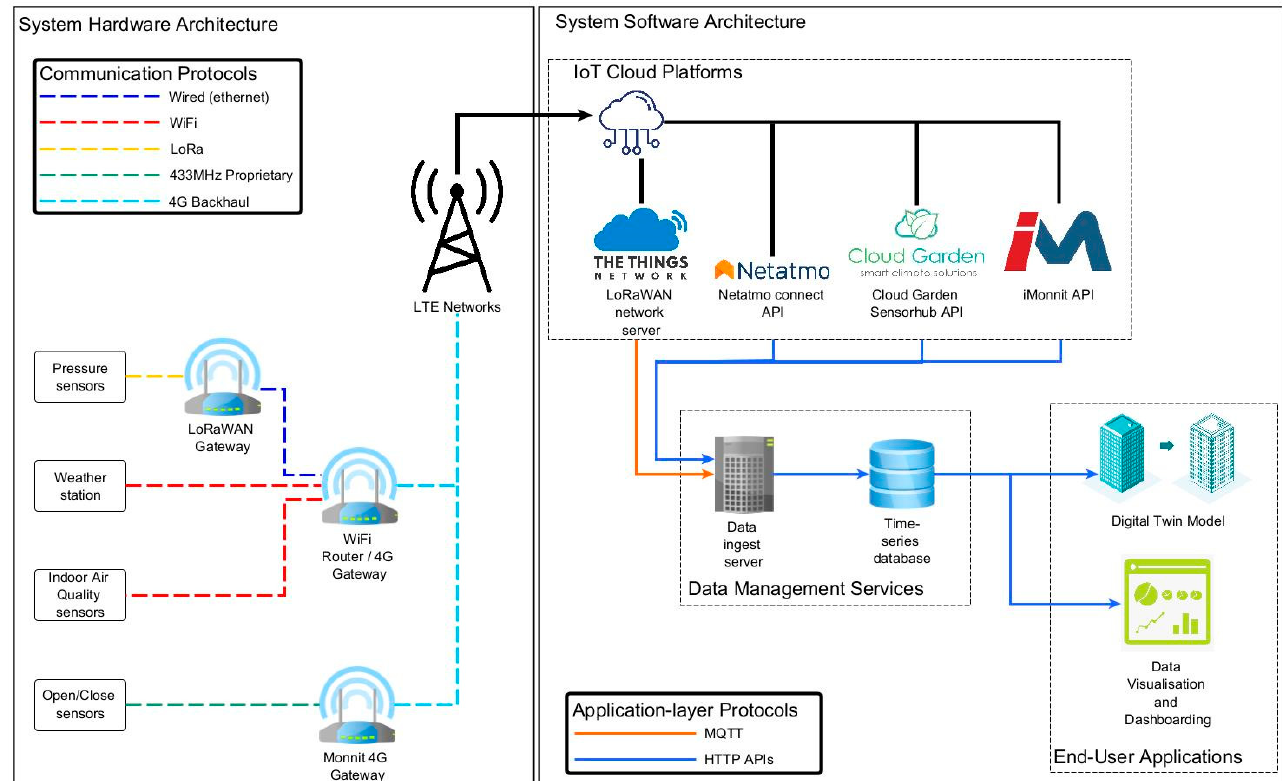
Figure 5. Monitoring system hardware and software architecture shows logical interconnections and communication protocols.